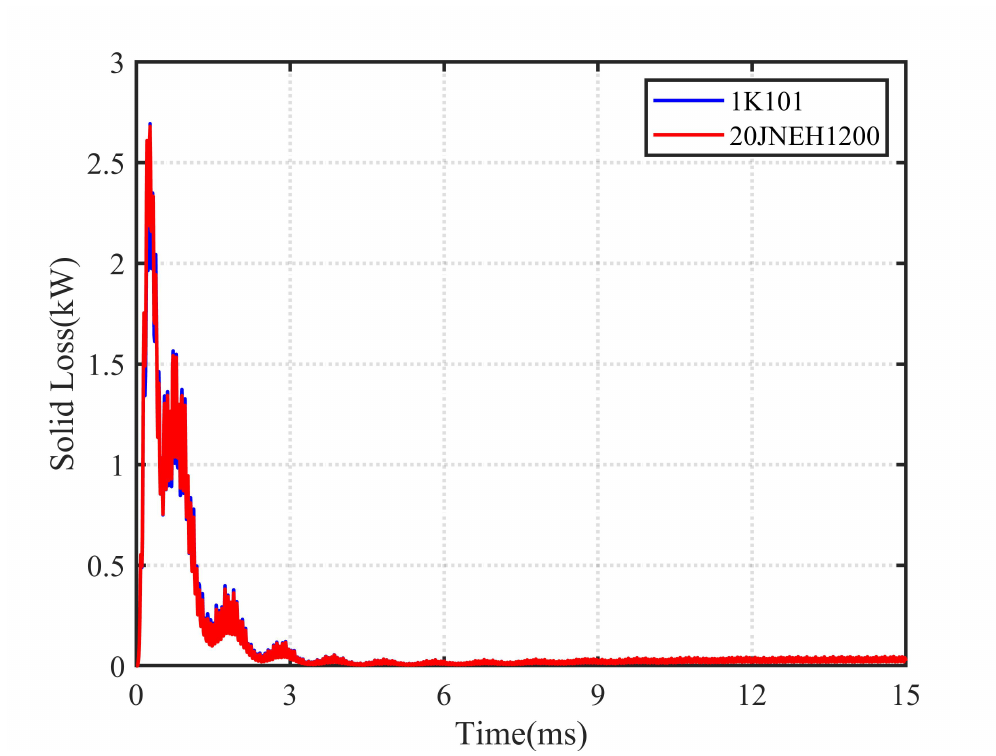
Figure 7. Comparison of the Copper Loss in the Rotor